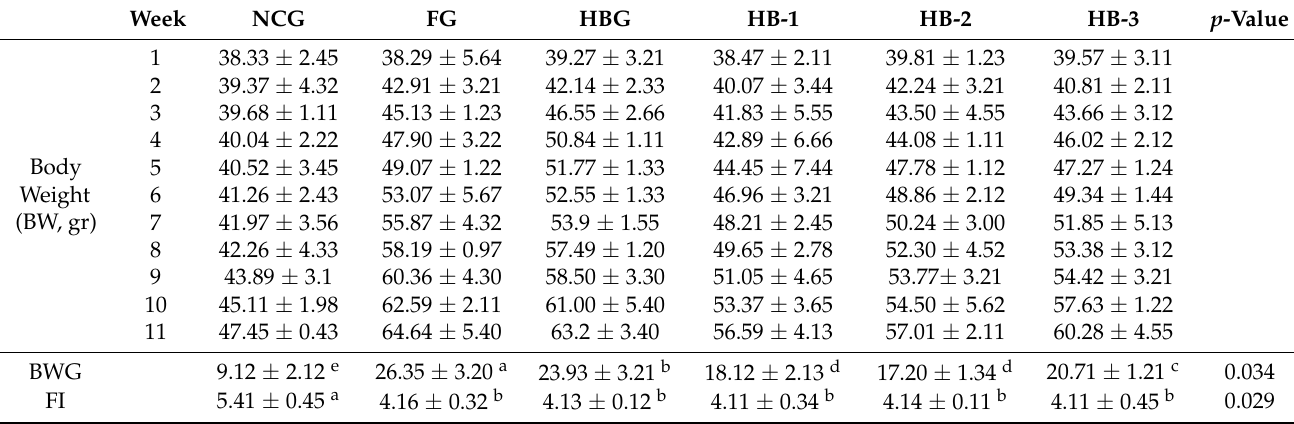
Table 3. The BW, BWG, and FI of NCG, FG, HB, HB-1, HB-2, and HB-3.